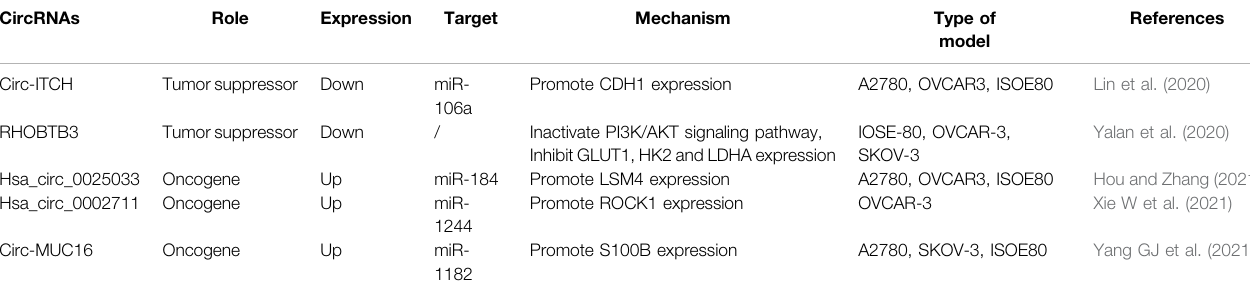
TABLE 3 | circRNAs involved in glycolysis in ovarian cancer.